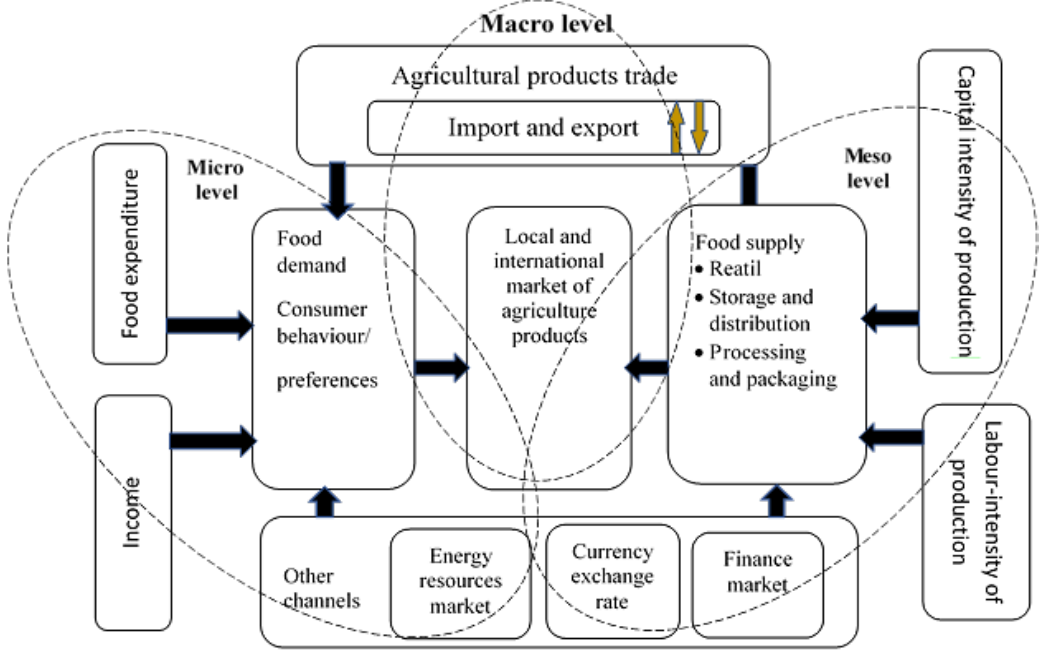
Figure 1. The main transmission channels of the COVID-19 pandemic impacts to food security and agriculture in the context of macro, meso and micro levels [6]